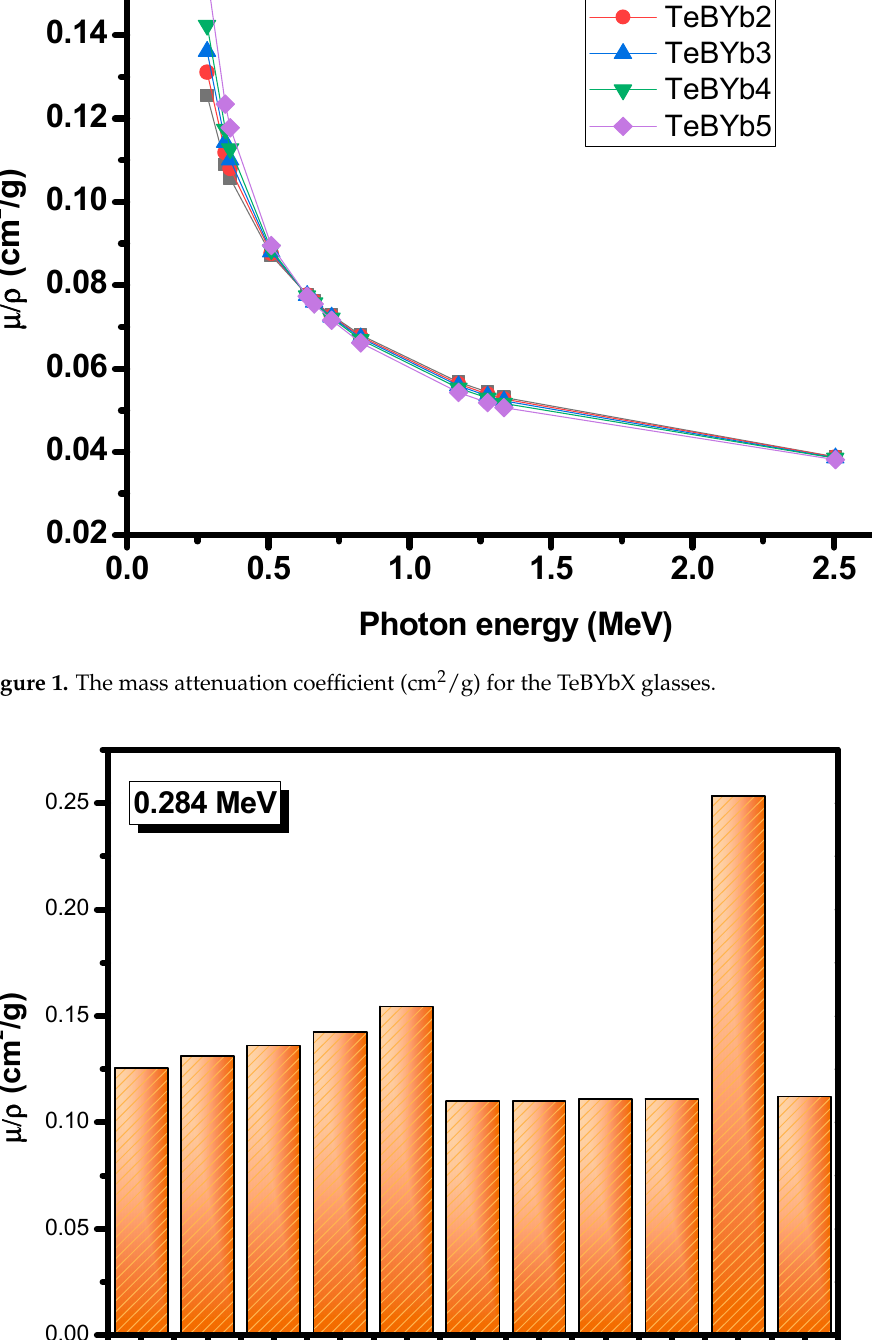
Figure 2. Comparison between the mass attenuation coefficient (cm 2 /g) for the TeBYbX glasses with some traditional glasses at 0.284 MeV.